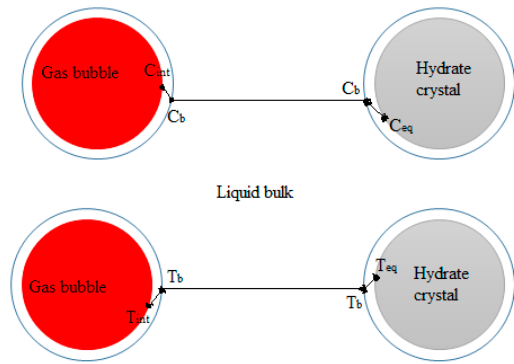
Figure 2. Schematic illustration of gas-liquid and crystal-solution interfaces for mass transfer of gas through the bulk phase to the crystal surface in a hydrate forming system (concept has been adopted from Mork (2002) [58]).